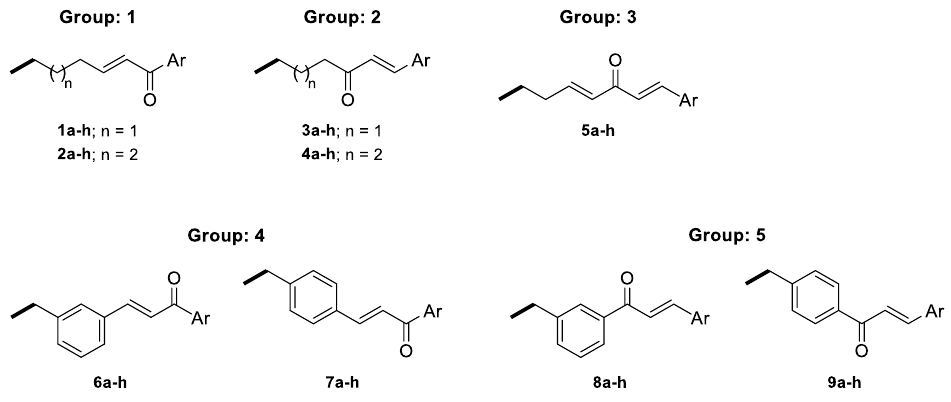
Figure 3. Linkers used in the designed GAL-CU hybrid molecules.